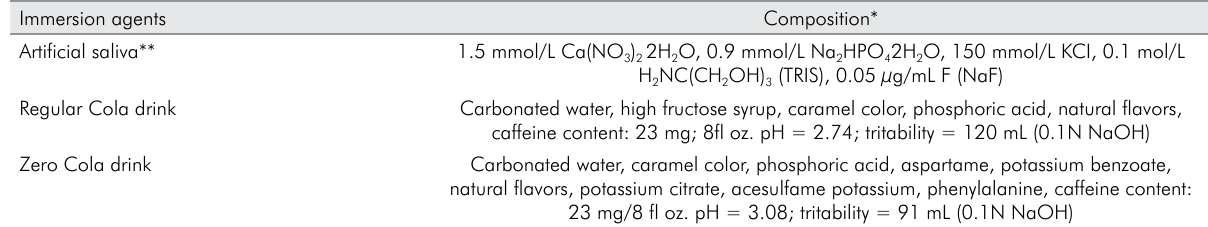
Table 1. Comparison of immersion